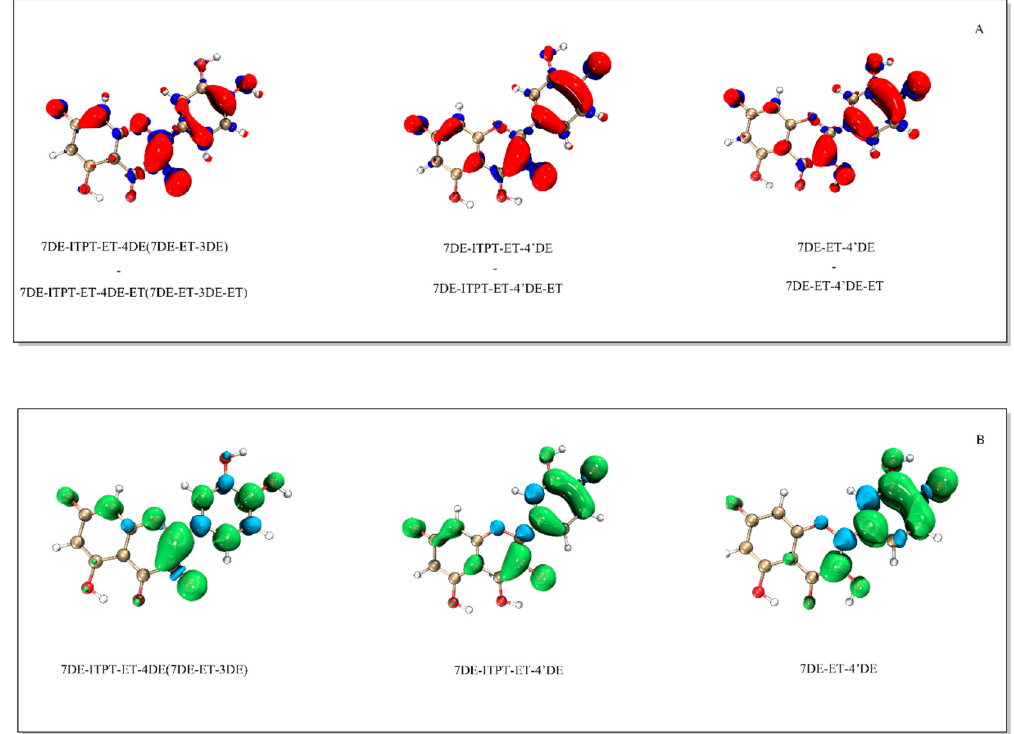
Figure 7. The electron density difference of the three forms of the Q radical with their corresponding quinone (panel ( A )) and the spin density of the three forms of the Q radical (panel ( B )).